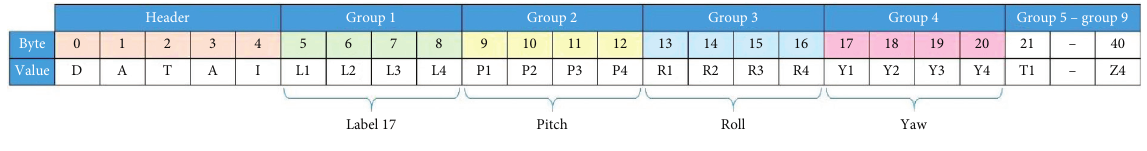
Figure 10: Packet format.